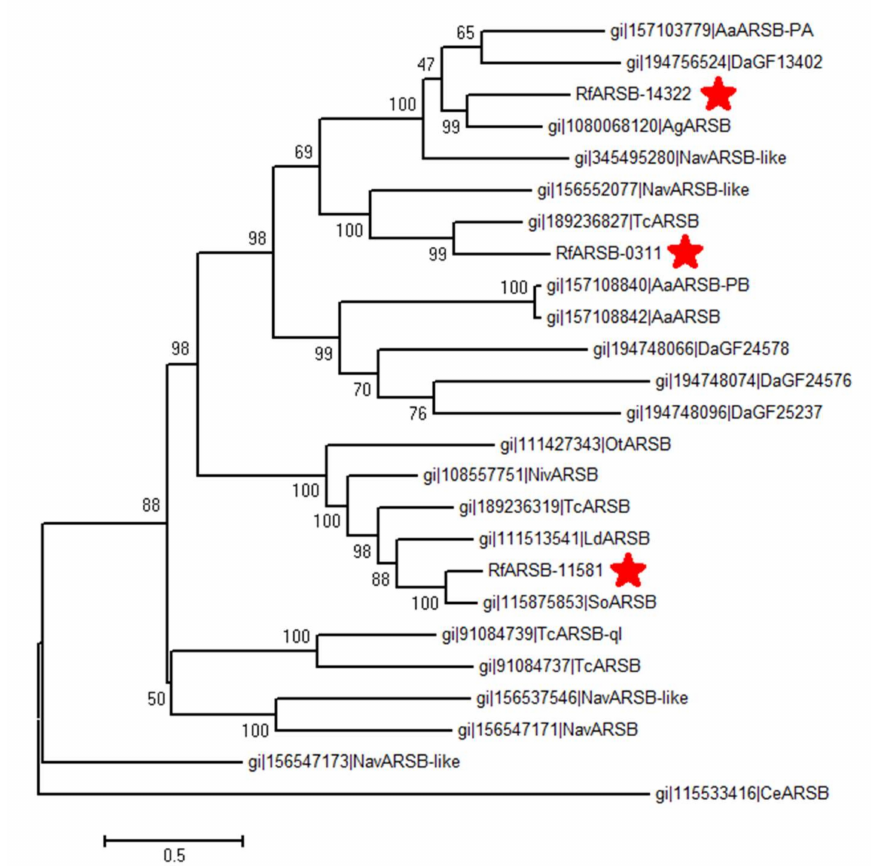
Figure 1. Phylogenetic tree of homologs of the three novel arylsulfatase B (ARSB) proteins from R. ferrugineus with other known insect and nematode ARSBs. The amino acid sequences of the complete proteins were aligned to construct the dendrogram using the maximum likelihood (ML) method. Bootstrap values shown next to nodes were based on 1000 repetitions. The scale on the bottom of the dendrogram shows the degree of dissimilarity. The abbreviations of species names and accession numbers of the corresponding protein sequences in GenBank are as follows: Aa, Aedes